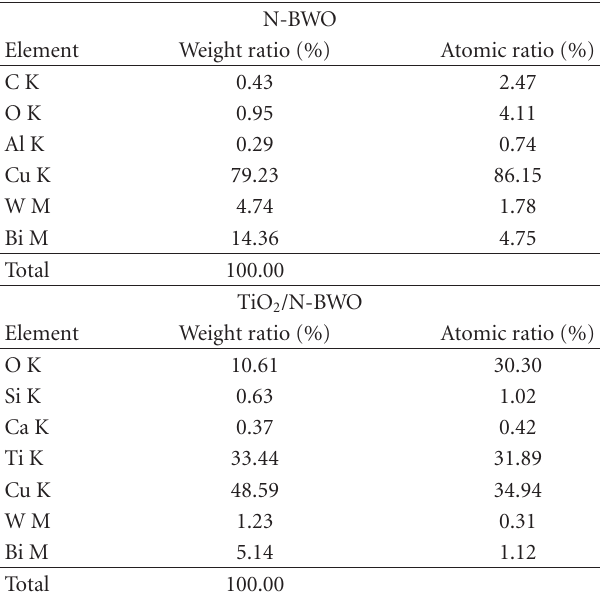
Table 3: Characterization data of EDS for N-BWO and TiO 2 /N- BWO